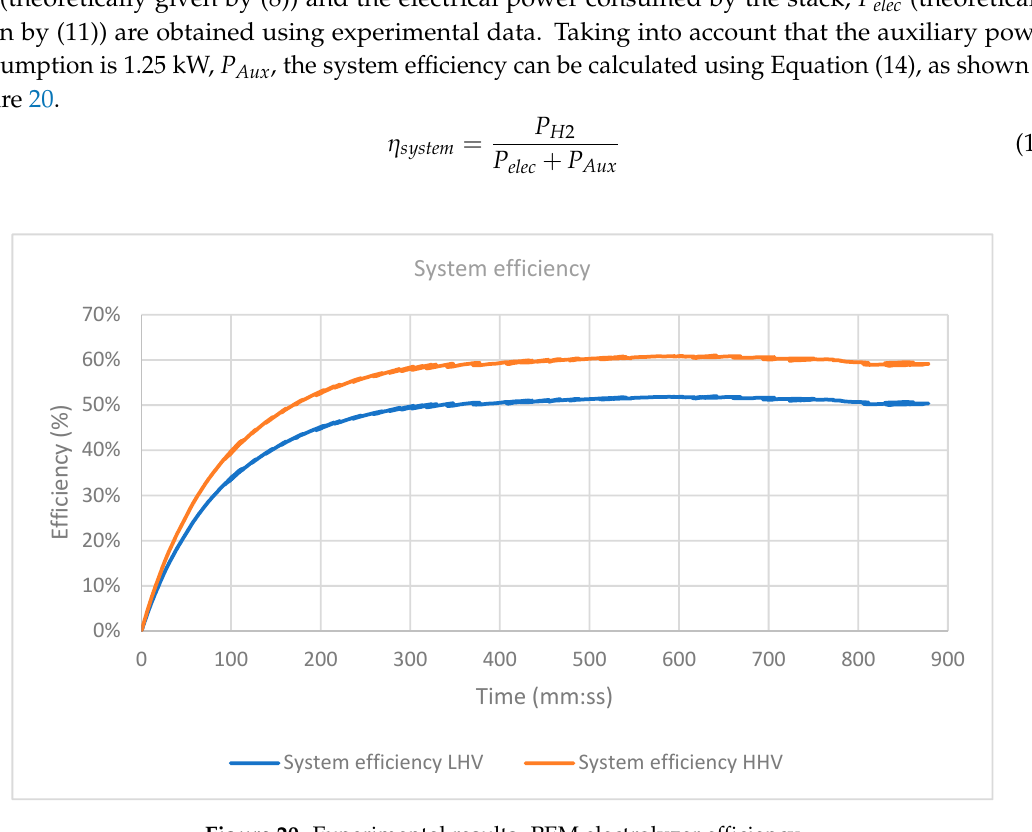
Figure 20. Experimental results. PEM electrolyzer efficiency.